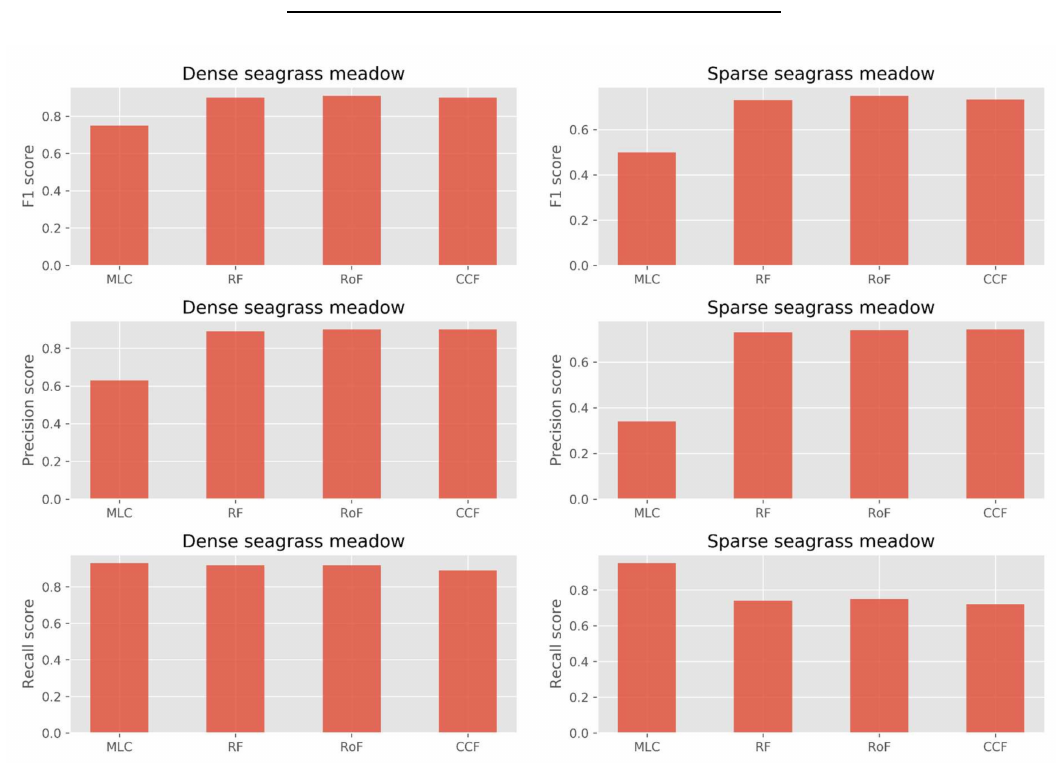
Figure 4. A comparison of the F1, precision, and recall scores for the Sentinel-2 scene (5 / 1 / 2019) using ensemble-based and traditional